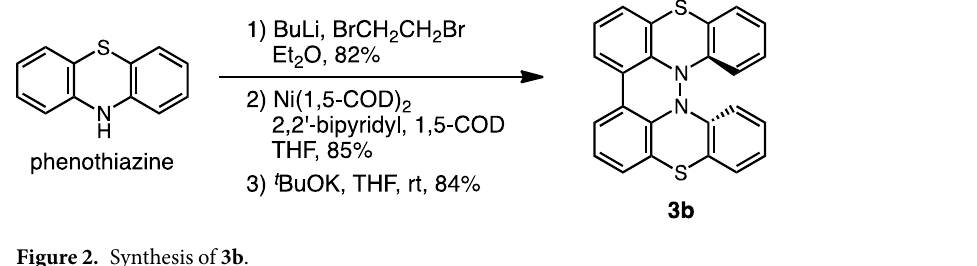
Figure 2. Synthesis of 3b